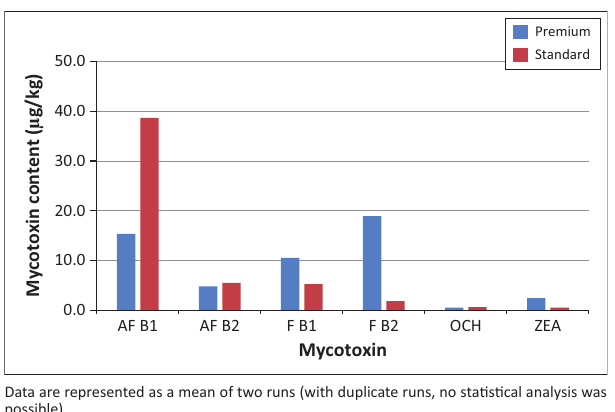
FIGURE 1: High-performance liquid chromatography quantitation of the four major mycotoxins investigated in this